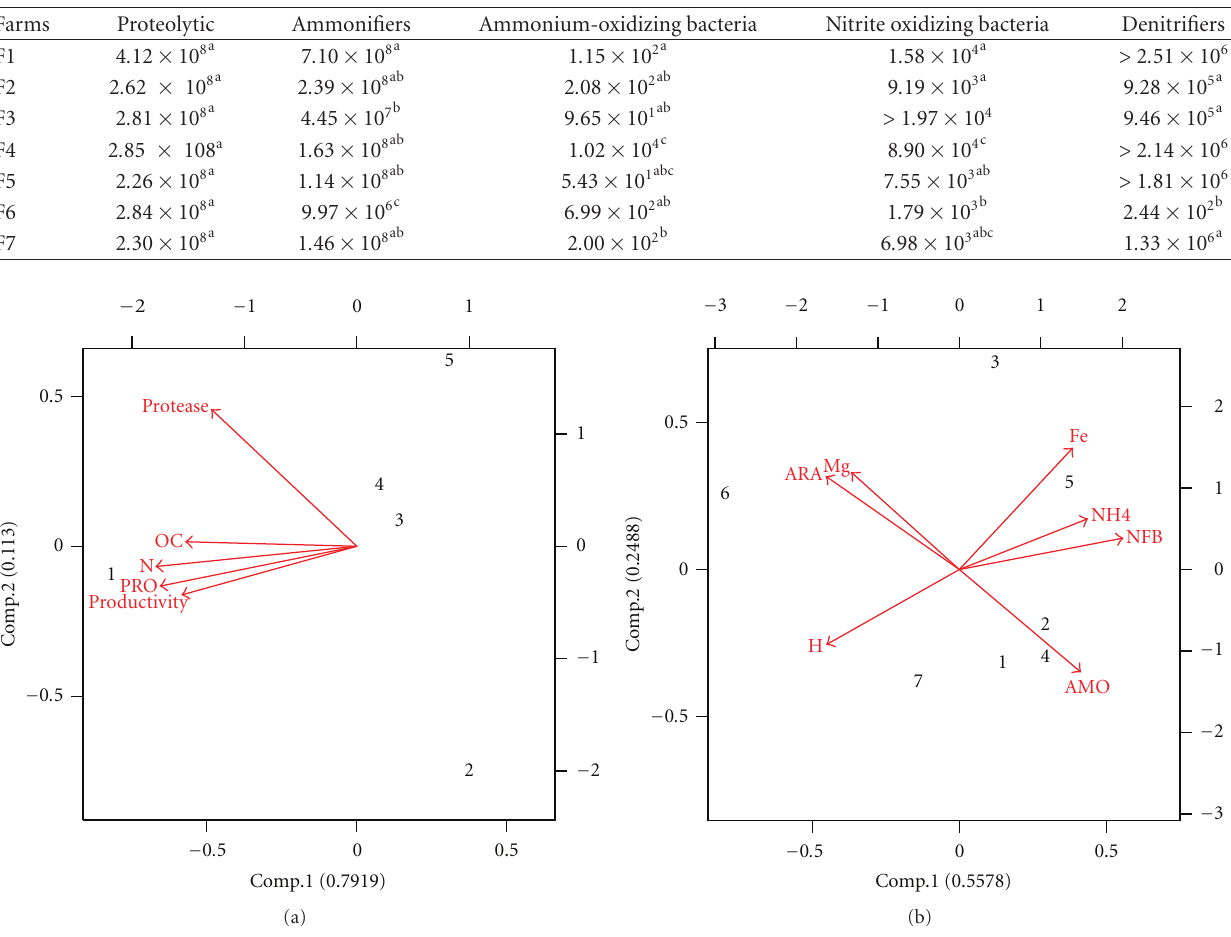
Figure 5: Principal component analysis of physical-chemical, biochemical, and biological data related to nitrogen cycle. The parameters represented in this analysis were: (a) protease: protease activity, OC: organic carbon, N: percentage of total nitrogen, PRO: proteolytic bacteria counts, productivity: crop productivity, and (b) ARA: nitrogenase activity, Mg: magnesium, H: moisture percentage, AMO: ammonifiers, NFB: nitrogen-fixing bacteria counts, NH4: ammonium, Fe: